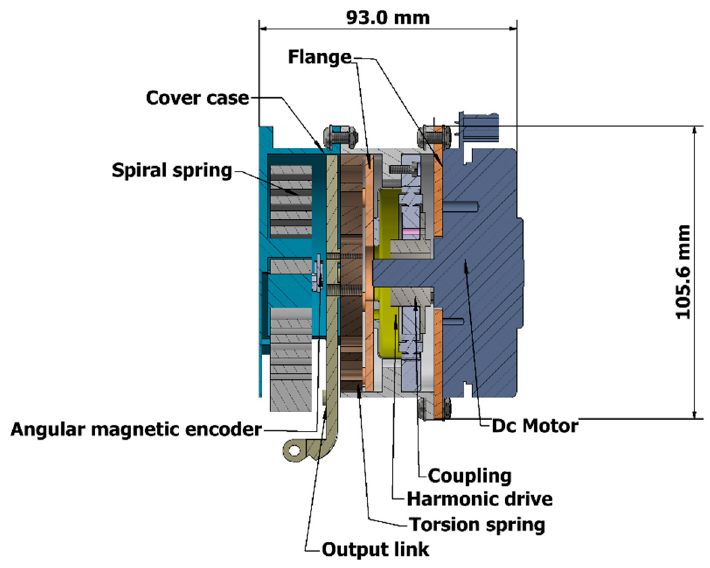
Figure 3. Cross-section of ES-RSEA.